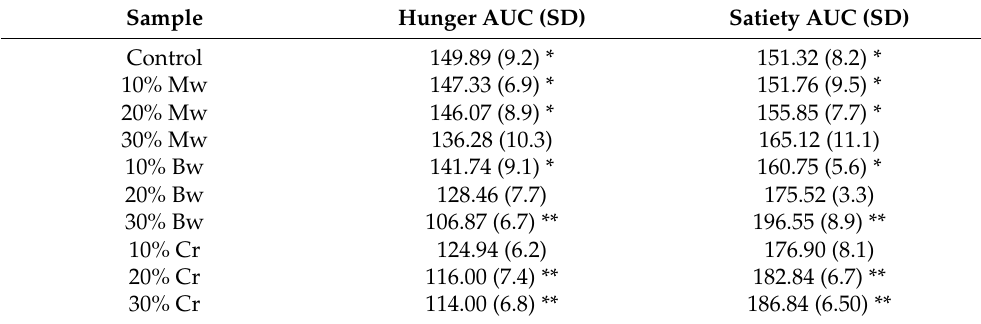
Table 4. The determined areas under the curve (AUC) for the assessment of hunger and satiety in test